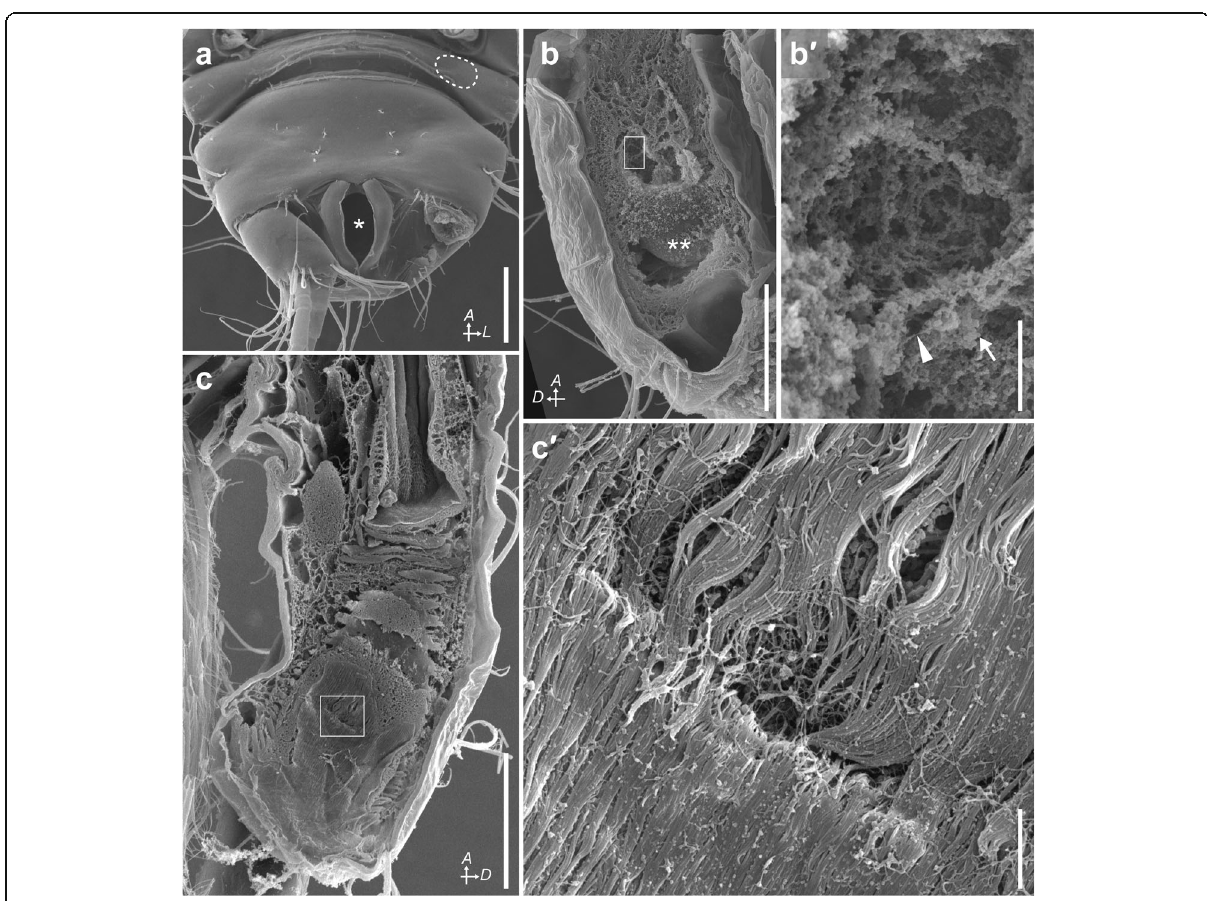
Fig. 4 SEM images of the pleotelson in P. algicola . a Pleonite 5 and pleotelson, ventral view, with left uropod detached; *, anal opening; dotted circle indicates the presumed region from which left pleopod 5 has been evolutionarily lost. b , c Sagittal plane of pleotelson, showing glandular cavity ( b ) and opening of glandular duct ( c ); **, acinar gland. b ′ , c ′ Enlargements of boxed areas in b and c , respectively; arrow and arrowhead indicate barrel-shaped and filament-like secretions, respectively. Abbreviations: A , anterior; D , dorsal; L , left. Scale bars: 100 μ m for a – c ; 5 μ m for b ′ , c